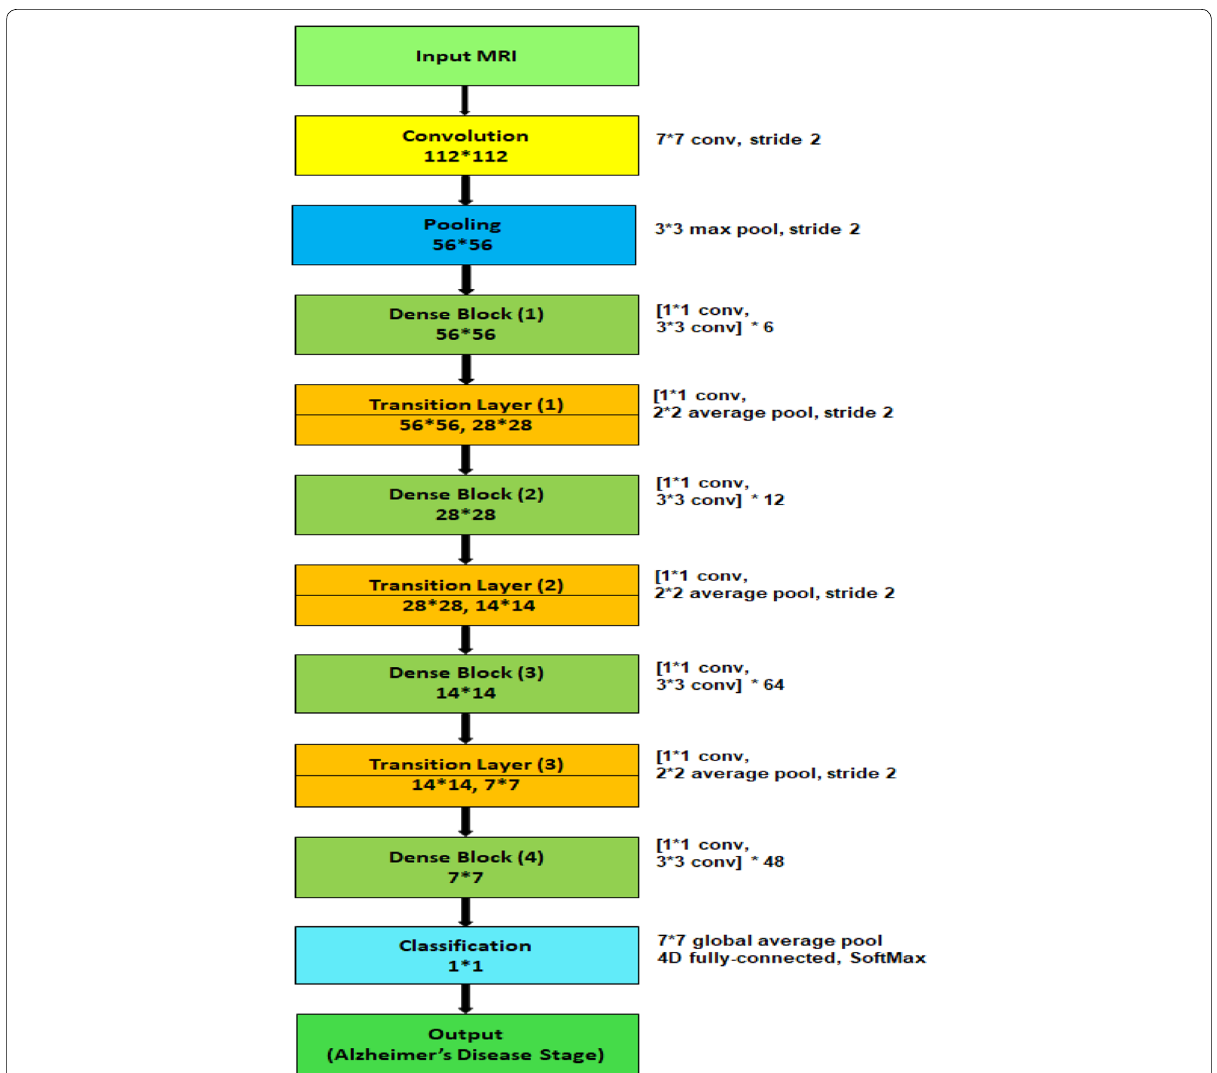
Fig. 7 Block diagram of individual model M 5